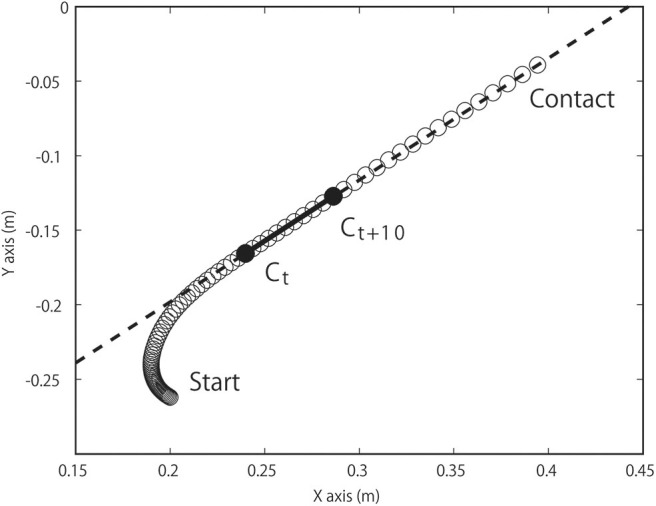
The COM trajectory was used to define the fore-aft axis in the horizontal plane of one trial. The fore-aft axis (dotted line) was along the line connecting the COM coordinates when the COM horizontal speed exceeded 1 m/s (Ct) with that 10 frames later (0.05 s later, Ct+10). X and Y denote global coordinates. COM, center of mass.